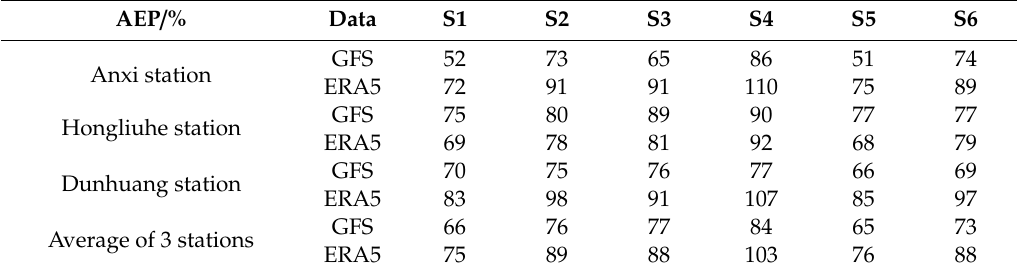
Table 4. AEPs at di ff erent stations and averaged AEPs at three stations under di ff erent combinations of initial data and parameterization schemes.